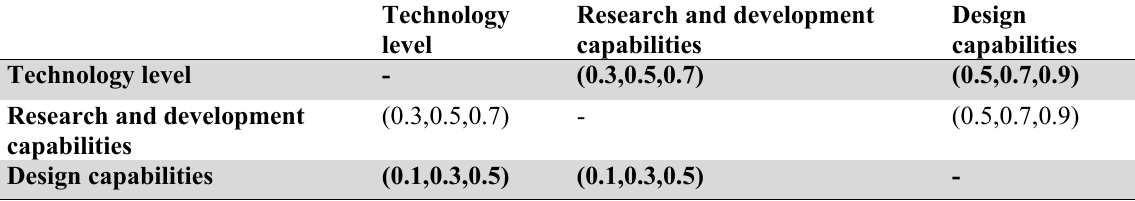
Paired-wise comparison of technology